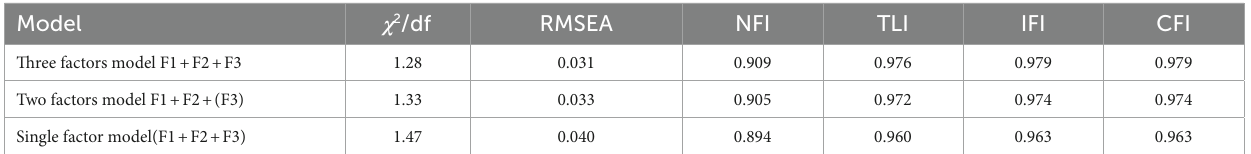
TABLE 5 Fit Parameters of the Hypothetical